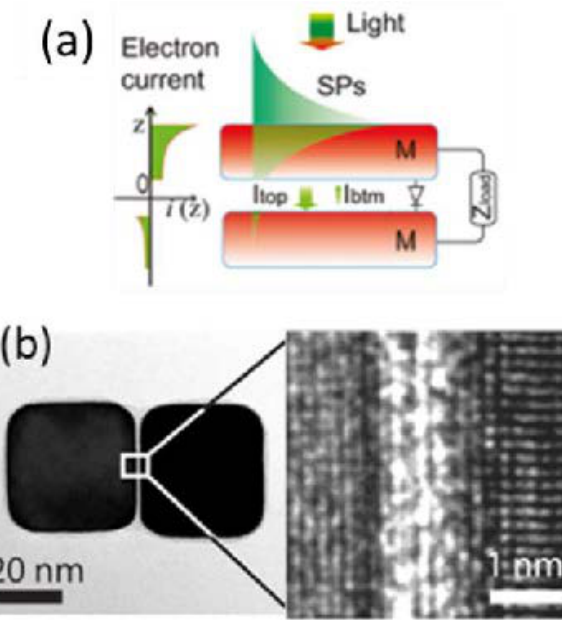
Figure 15: (a) Schematic of an MIM optical energy converter. Sur- face plasmon enhanced hot electrons in the top electrodes can largely increase the forward current and hence a net DC photocur- rent is generated. (b) TEM image of quantum plasmonic tunnel junc- tions made of two silver nanoparticles bridged by a self-assembled monolayer in which CTP has been measured. Figures with reprint permission from: (a) Ref. [234] ©2011 American Chemical Society, and (b) Ref. [241] ©2014